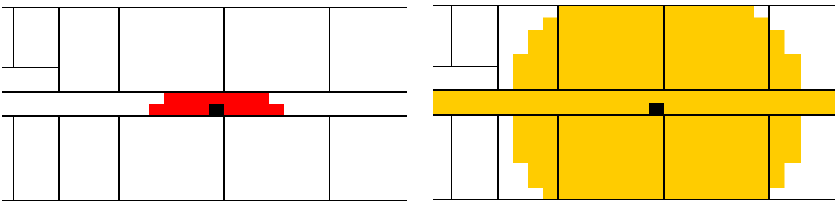
Figure 2. Zone 1 (in red) for the module in black, located in the middle of the corridor, and Zone 2 (in yellow), overlapping.